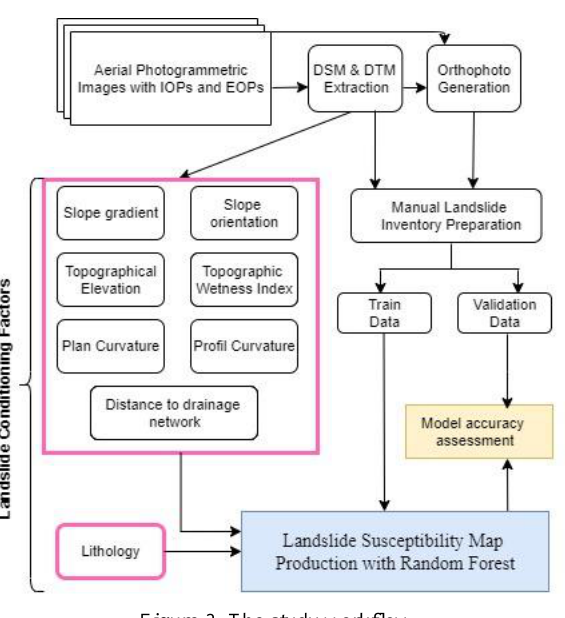
Figure 3. The study workflow.